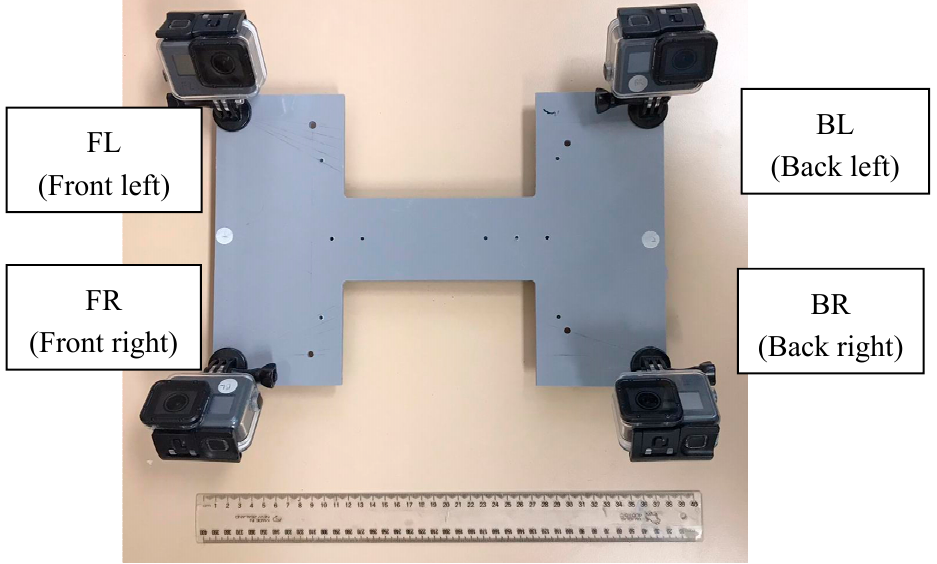
Figure 2. Camera frame with GoPro housings. The ruler length is 30cm.